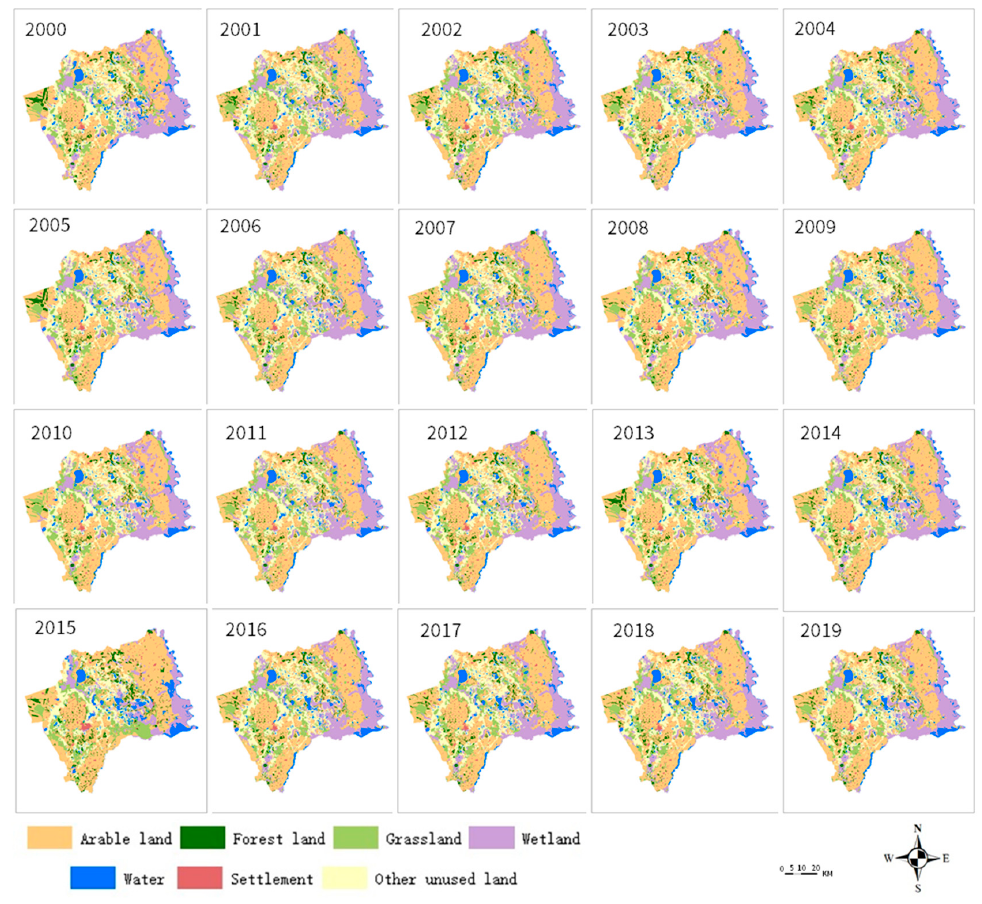
Figure 13. 2000–2019 LUCC reconstructions.